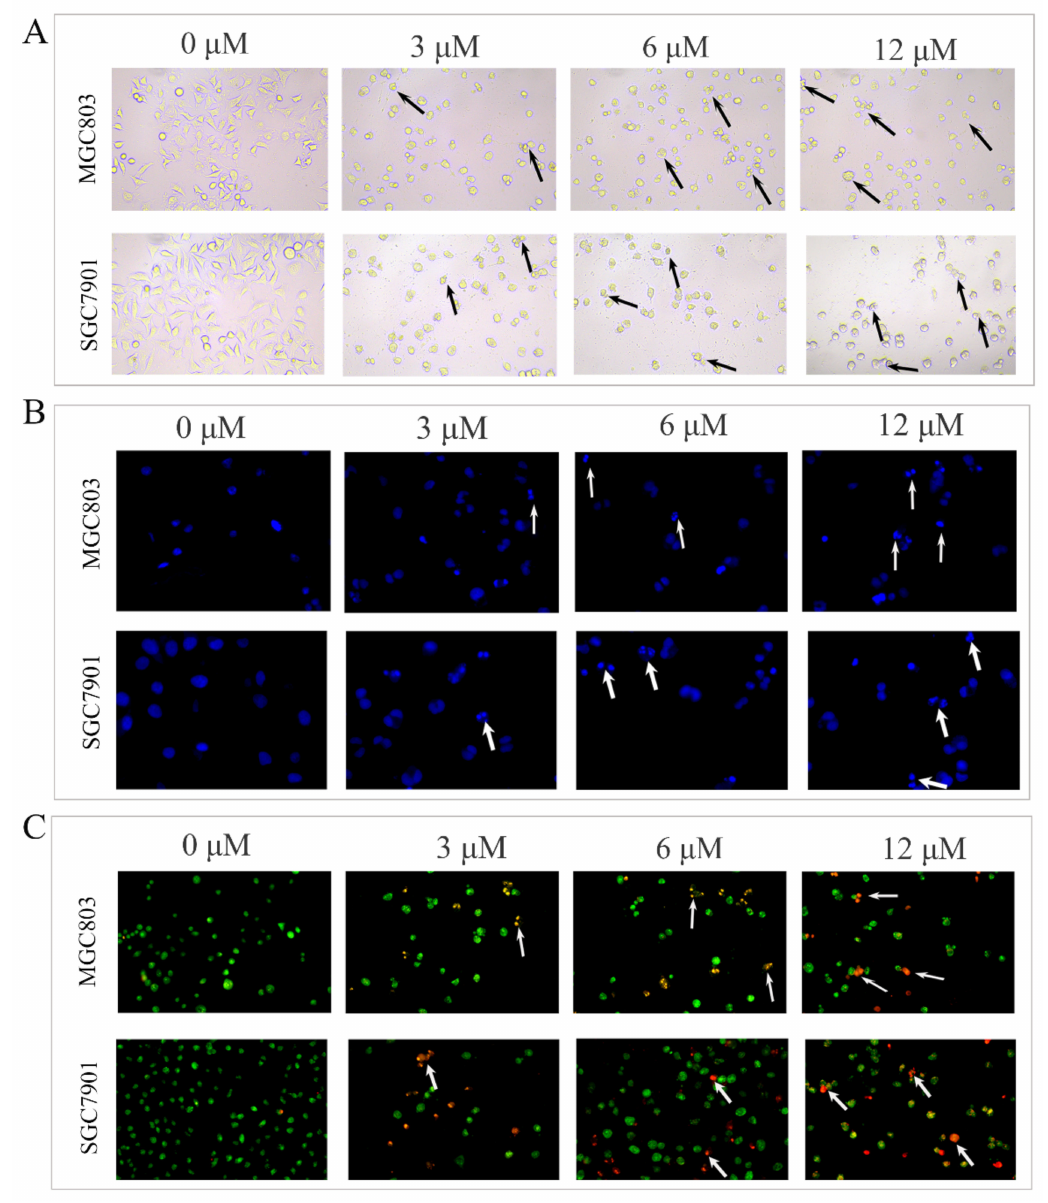
Figure 2. DHCE induced morphological changes of gastric cancer cells. ( A ) Morphology of MGC803 and SGC7901 cells treated with DHCE or not were observed under inverted microscope with a magnification of 200 × . ( B ) Chromatin condensation and nuclear fragmentation were observed by DAPI staining under fluorescence inverted microscope with a magnification of 200 × . ( C ) Normal cells, apoptotic cells, and necrotic cells were observed by AO/EB staining under a fluorescence inverted microscope with a magnification of 200 ×